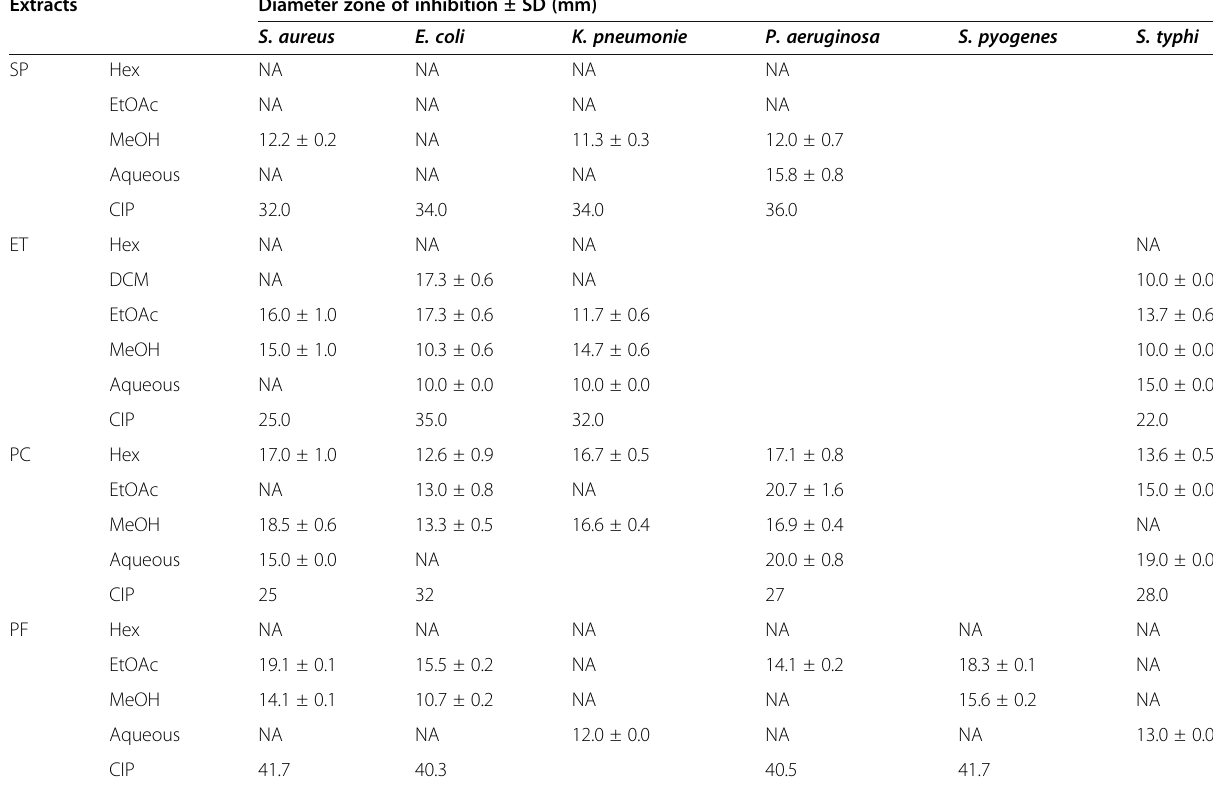
Table 1 Zone of inhibition of the different plant extracts against S. aureus , E. coli , K. pneumonie , P. aeruginosa , S. pyogenes , and S. typhi Extracts